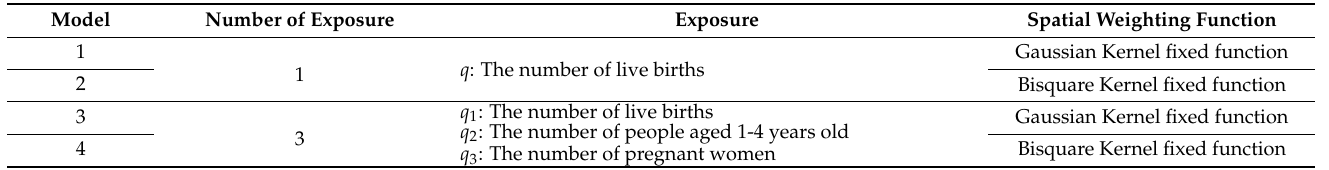
Table 1. Model Specifications.